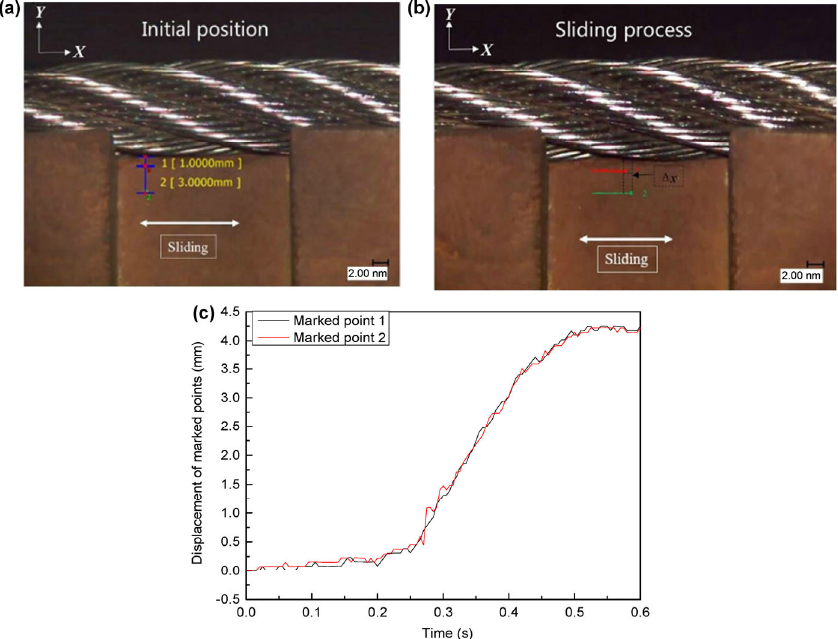
Fig. 4 Tracking the displacement of marked points 1 and 2 in the friction process: (a) Initial position, (b) sliding process, and (c) displacement of marked points 1 and 2 in the sliding